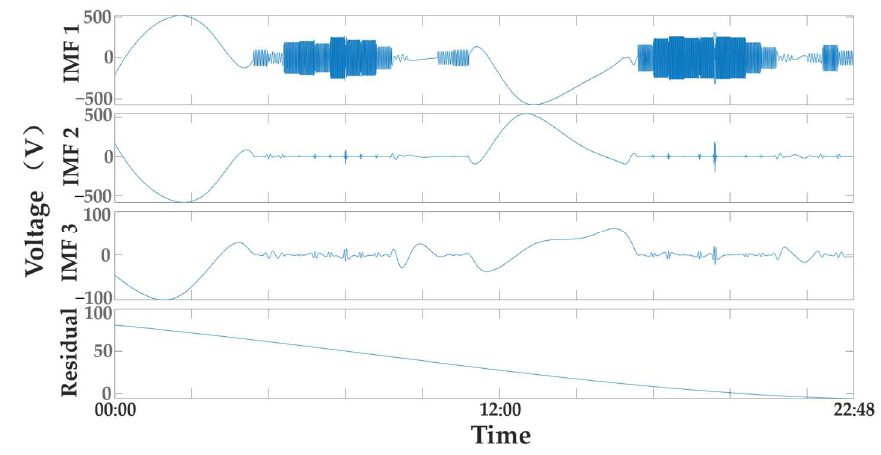
Figure 4. The EMD decomposition of the daily generation waveform of tidal power.